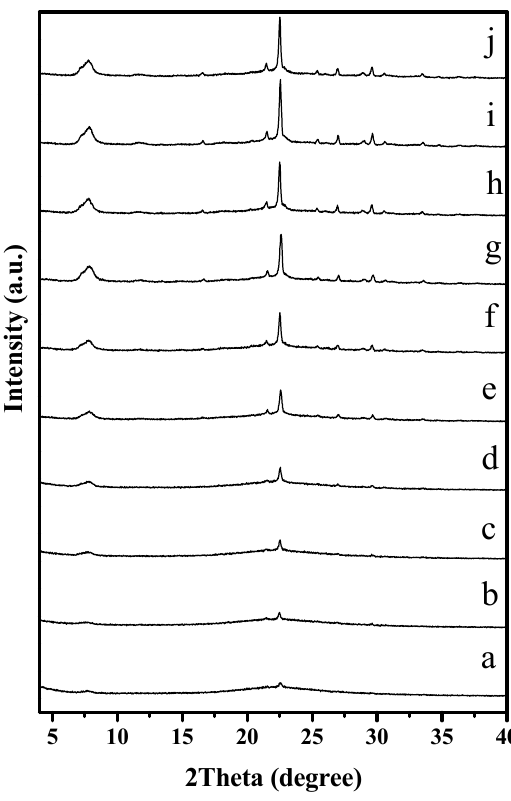
Figure 7. XRD patterns of S-Beta samples with tetragonal P4 1 22 crystallized for ( a ) 0; ( b ) 3; ( c ) 6; ( d ) 12; ( e ) 18; ( f ) 24; ( g ) 36; ( h ) 48; ( i ) 60 and ( j ) 72 h, respectively.